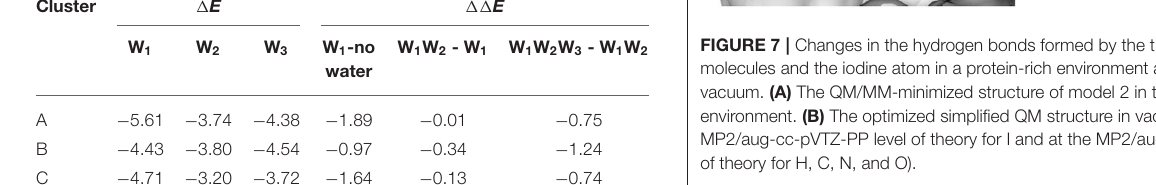
TABLE 2 | Halogen bond interaction energy 1 E (kcal/mol) of the representative structure for each cluster in the presence of different water molecules and the change in the halogen bond interaction energy, 1 E (kcal/mol), due to the presence of additional water molecules (at the MP2/aug-cc-pVTZ-PP level of theory for I and at the MP2/aug-cc-pVTZ level of theory for H, C, N, and O). Cluster 1 E 11 E W 1 W 2